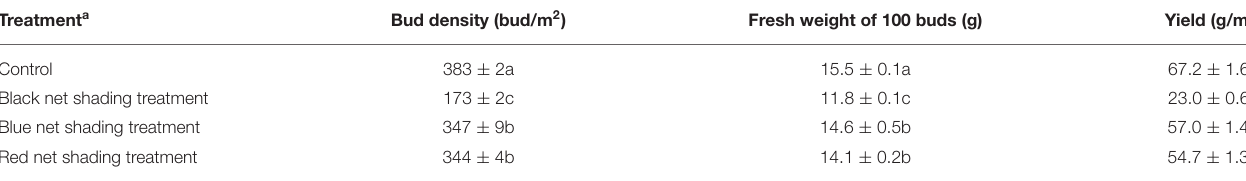
TABLE 1 | The biomass parameters of tea plants under different shading treatments. Treatment